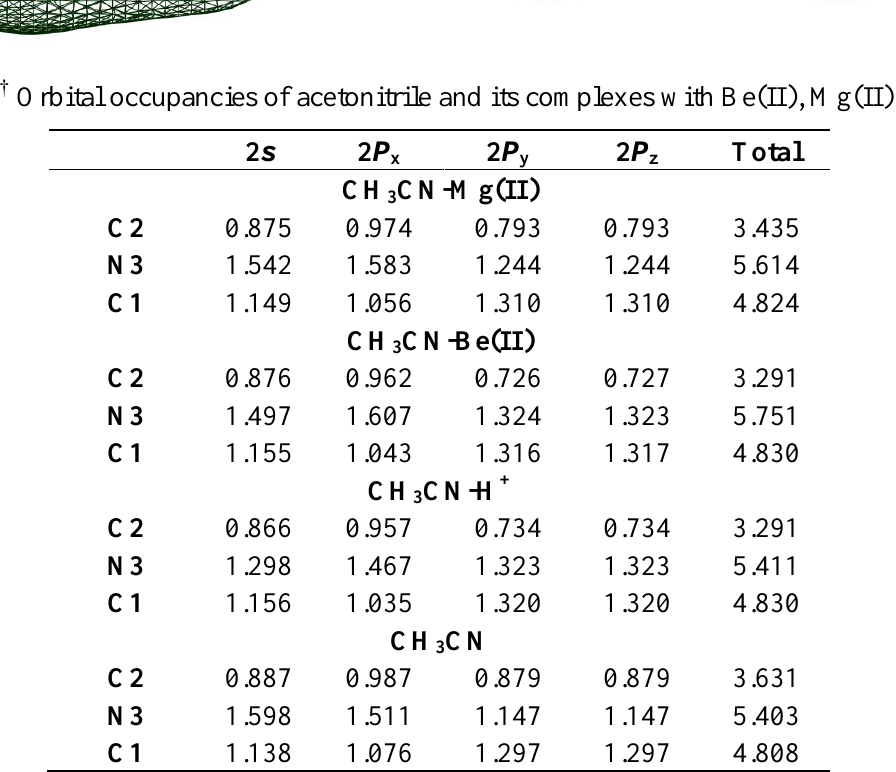
Figure 2. Selected G3 molecular orbitals of acetonitrile and its complexes with Mg(II). ( i ) HOMO-2 of CH ( v ) HOMO-4 of CH